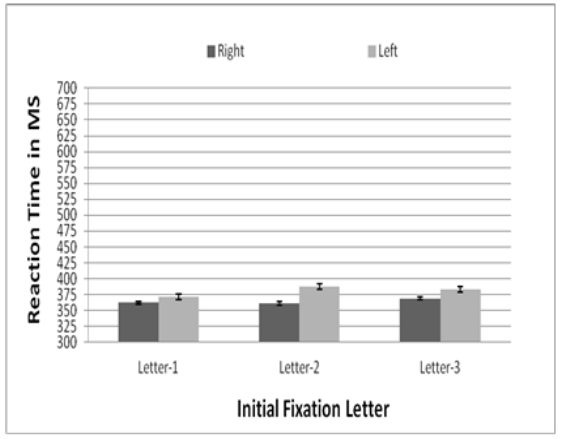
Figure 1. Time course of one trial in the optimal viewing position task Figure 2. Reaction time as a function of the po- sition of the unconnected word’s sub-units (right, left) and their initial fixation letters (first, second, third let - ter). Note: Error bars represent standard